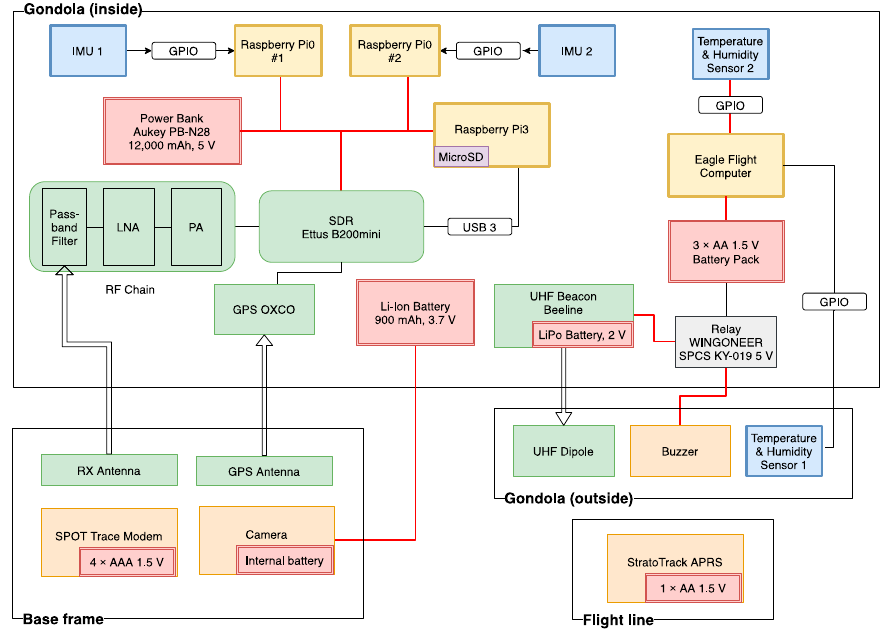
Figure 4. Schematics of the radio frequency (RF) payload and tracking payload arrangement.